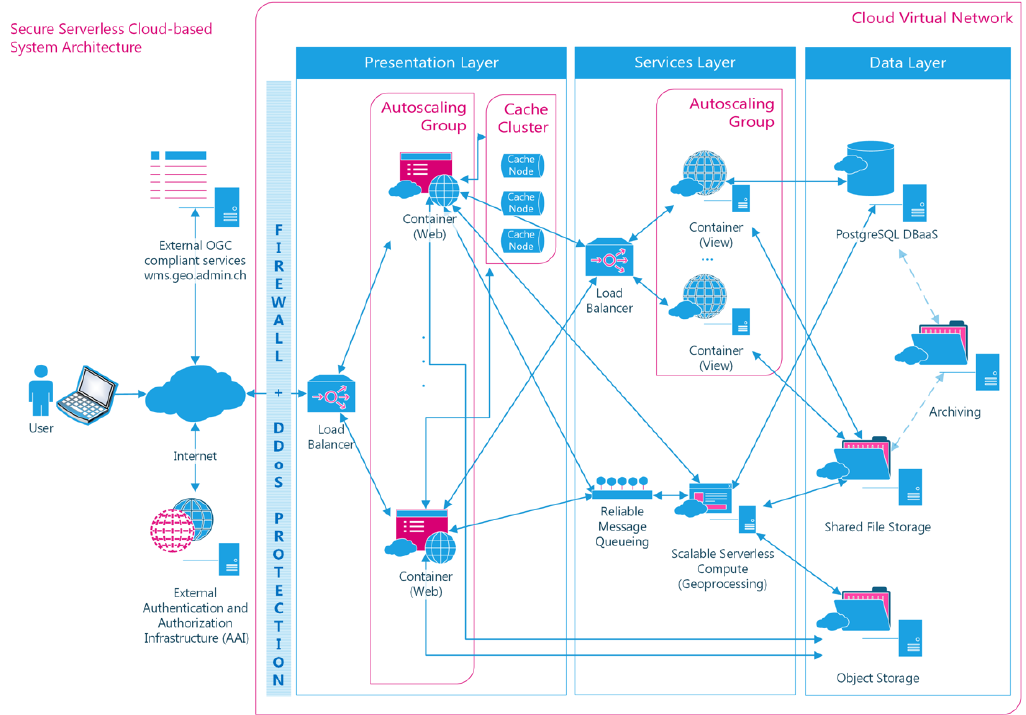
Figure 5. Secure cloud-based geoportal architecture using a serverless computing model.